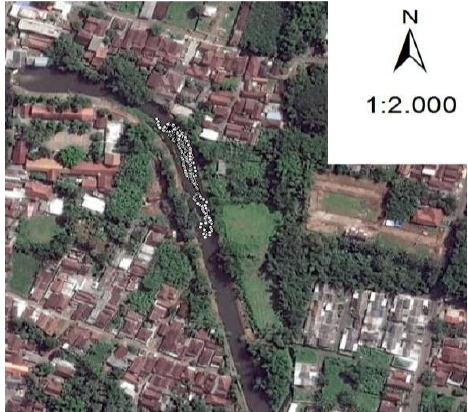
Figure 17. 3D visualization of Anyar River-floor (Suhari,